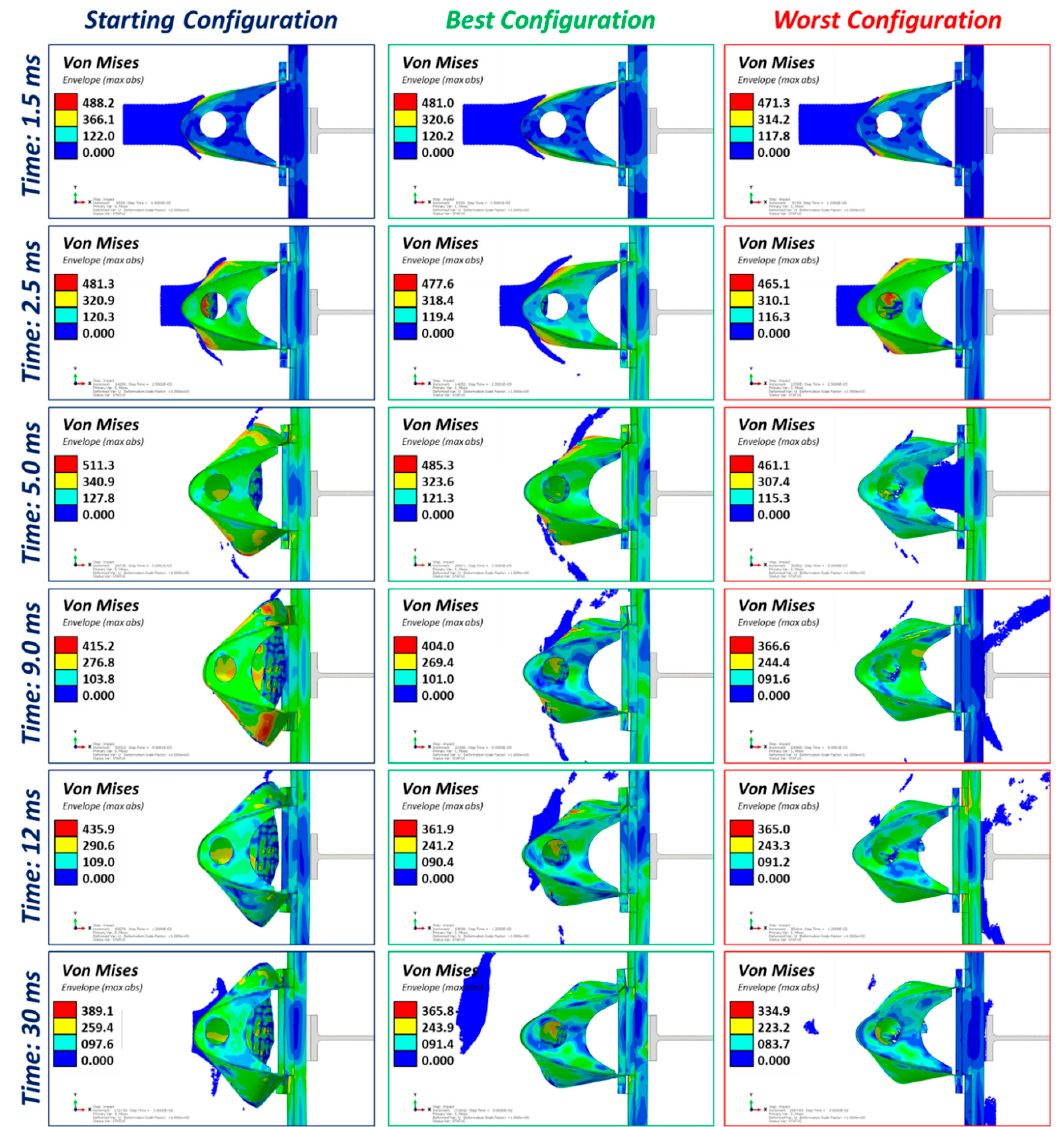
Figure 9. Von Mises stress for starting, best and worst configuration at different time steps.